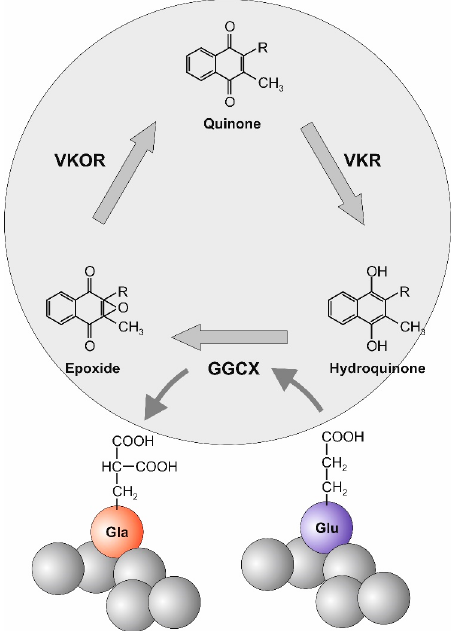
Figure 1. The vitamin K cycle. During γ -carboxylation of glutamyl residues, vitamin K becomes recycled via the vitamin K cycle: (1). The dietary quinone form is reduced to its hydroquinone form by vitamin K reductase (VKR). (2) During γ -carboxylation of Glu residues by γ -glutamyl car- boxylase (GGCX) the hydroquinone form of vitamin K is converted to its epoxide form. During this step, a Glu residue is γ -carboxylated to a Gla residue. (3) Vitamin K epoxide reductase converts vitamin K epoxide back to its original form.